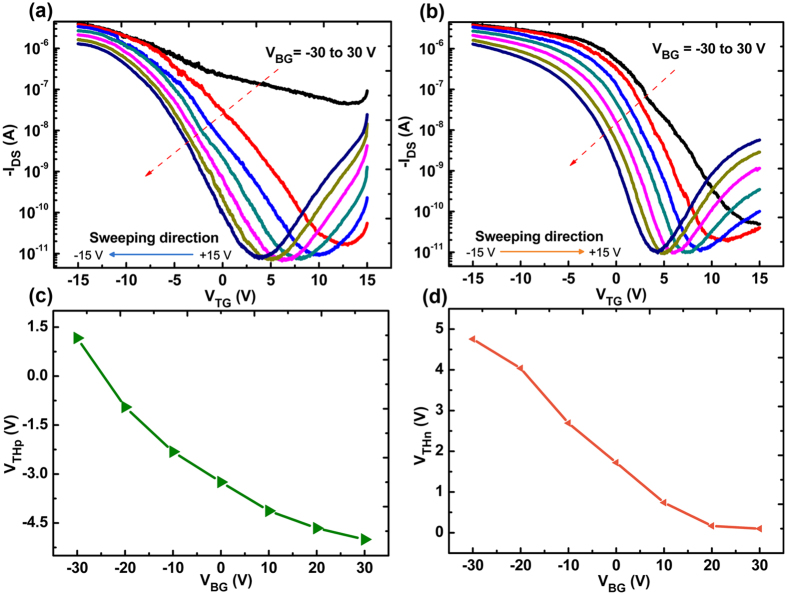
(a,b) The transfer curves of P(VDF-TrFE) top gate transistors are plotted as a function of VTG with the VBG ranging from −30 to 30 V under different sweeping directions. (c,d) The plot of threshold voltage (VTHp and VTHn) vs VBG.